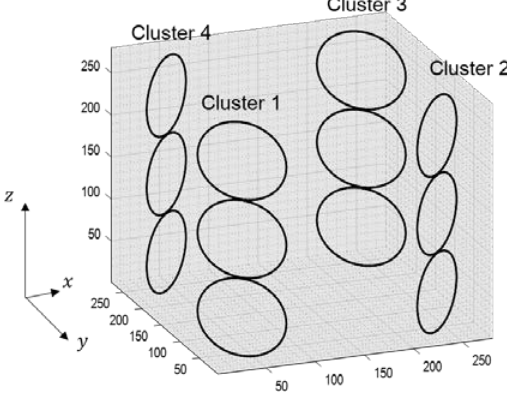
Figure 4. The structure of 12-channel head coil for computer simulation.